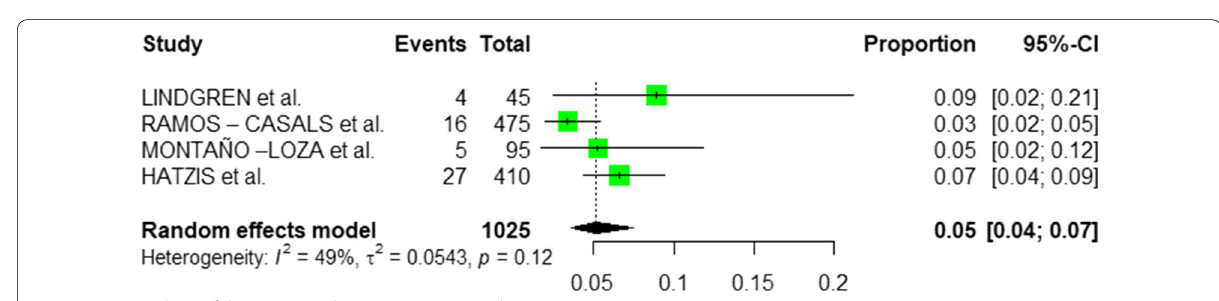
Fig. 2 Meta‑analysis of the PBC prevalence in Sjögren syndrome (pSS)